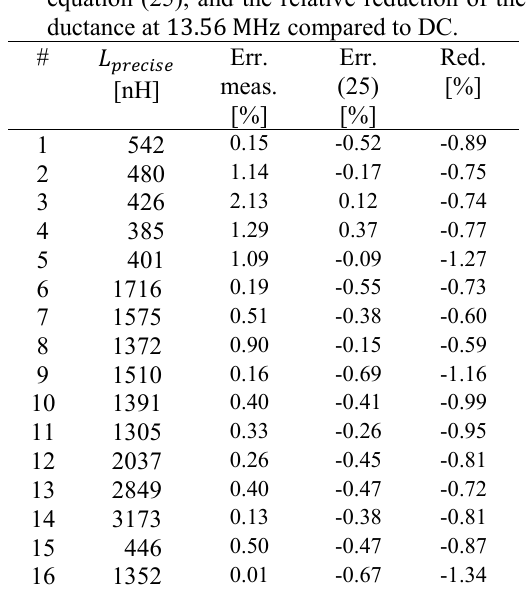
Table 4: Precise DC inductance 𝐿 𝑝𝑟𝑒𝑐𝑖𝑠𝑒 of the antennas from Table 3, the relative errors of the measurements, of equation (25), and the relative reduction of the in- ductance at 13.56 MHz compared to DC.